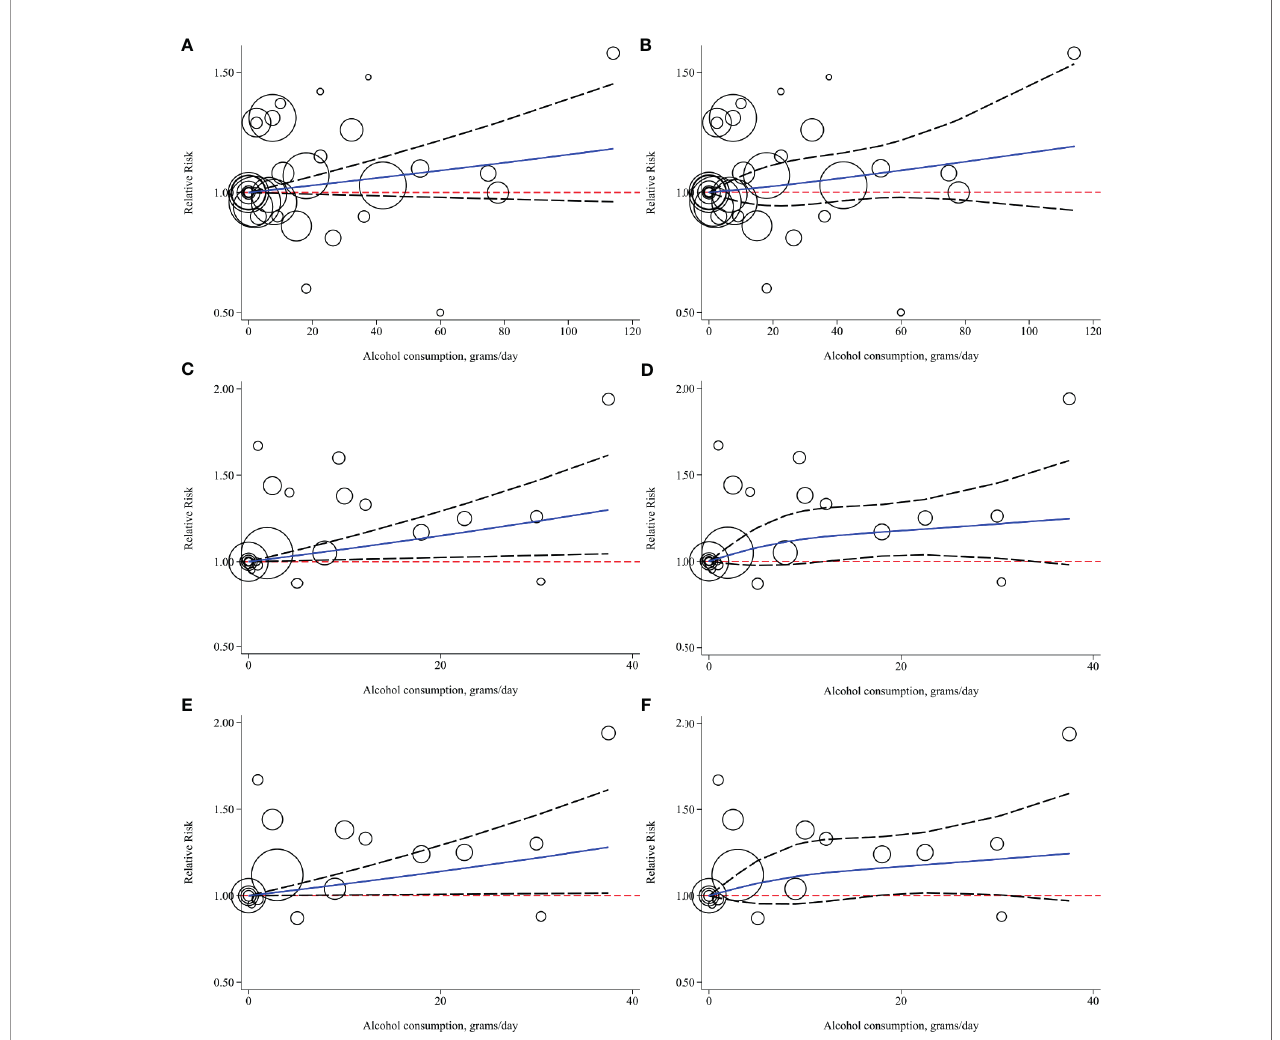
FIGURE 5 | Linear and nonlinear fi tting of alcohol consumption and risk of bladder cancer (A) linear association in entire population; (B) nonlinear association in entire population; (C) linear association in entire population who consumed alcohol for liquor or spirits; (D) nonlinear association in entire population who consumed alcohol from liquor or spirits; (E) linear association in males who consumed alcohol form liquor or spirits; (F) nonlinear association in males who consumed alcohol from liquor or spirits. (Bubbles were weighted by the number of cases at each